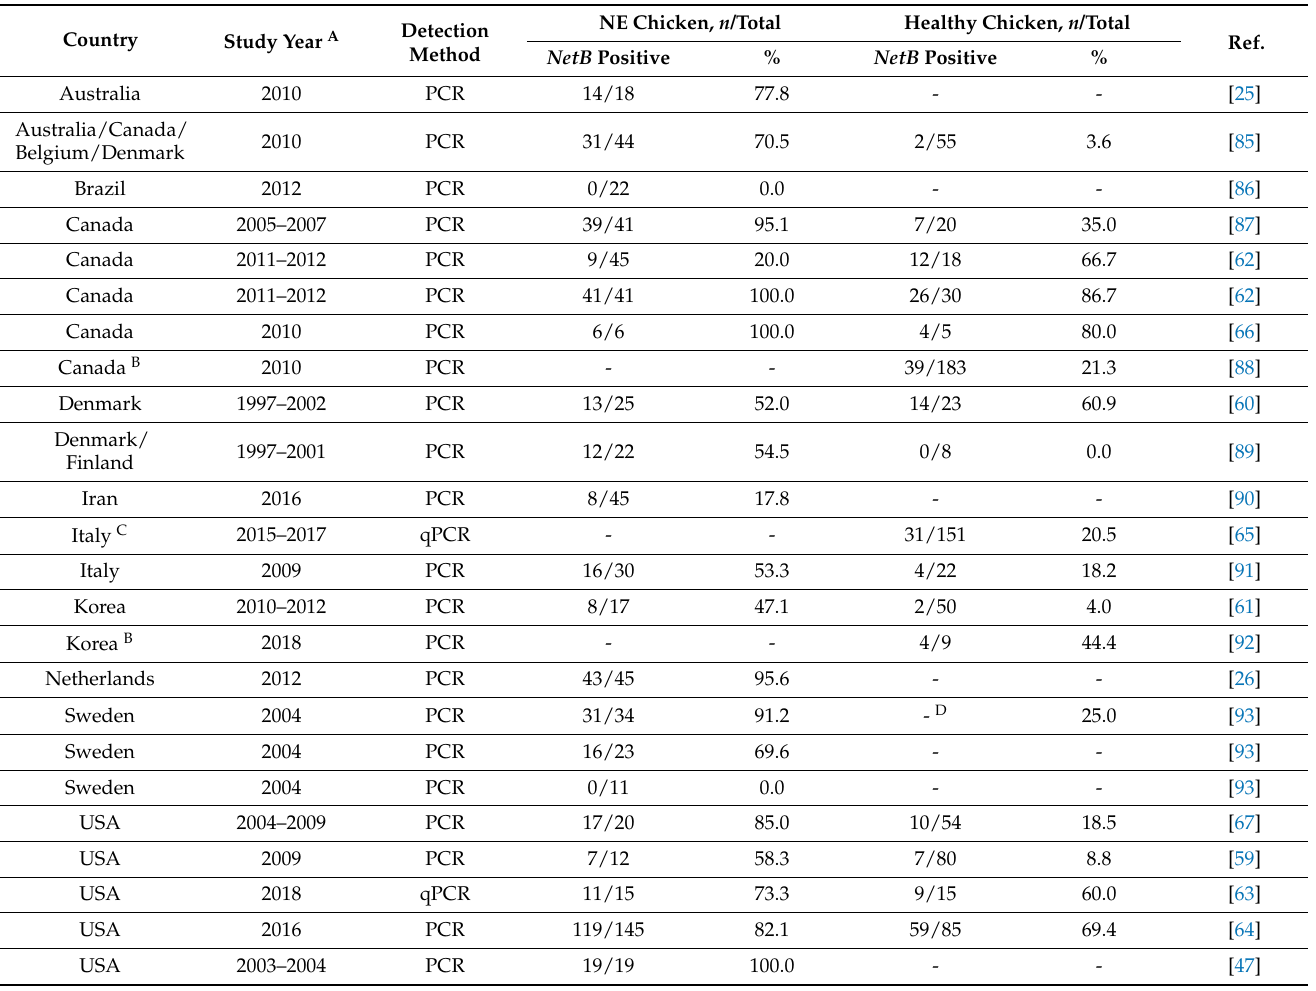
Table 4. Incidence of necrotic enteritis (NE) B-like toxin gene in Clostridium perfringens G isolates from retail chicken meats or chickens afflicted with or without clinical or subclinical